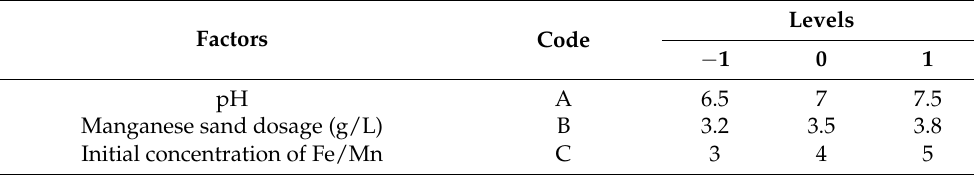
Table 1. Variables and experimental design levels for the Box–Behnken